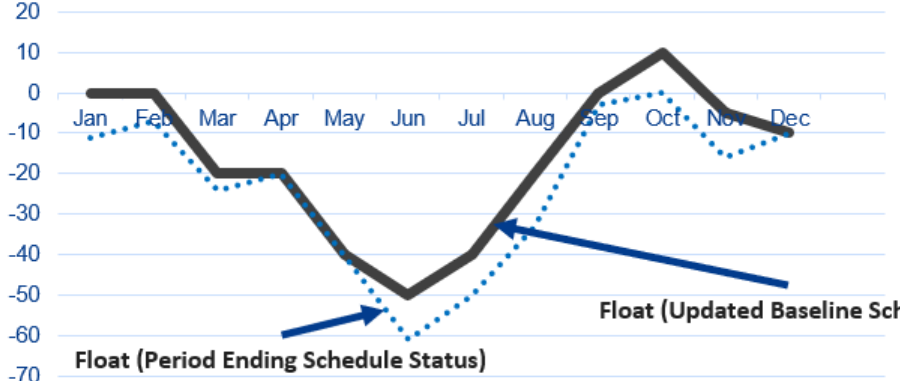
Figure 8. Float analysis and progress curves basis for schedule delays [adopted from Management Body of Knowledge